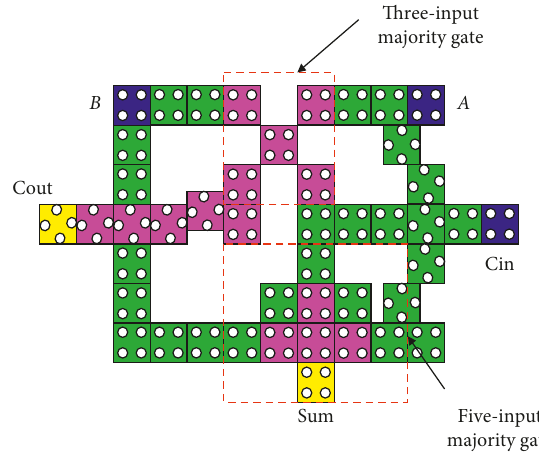
Figure 7: Proposed QCA layout of the FA